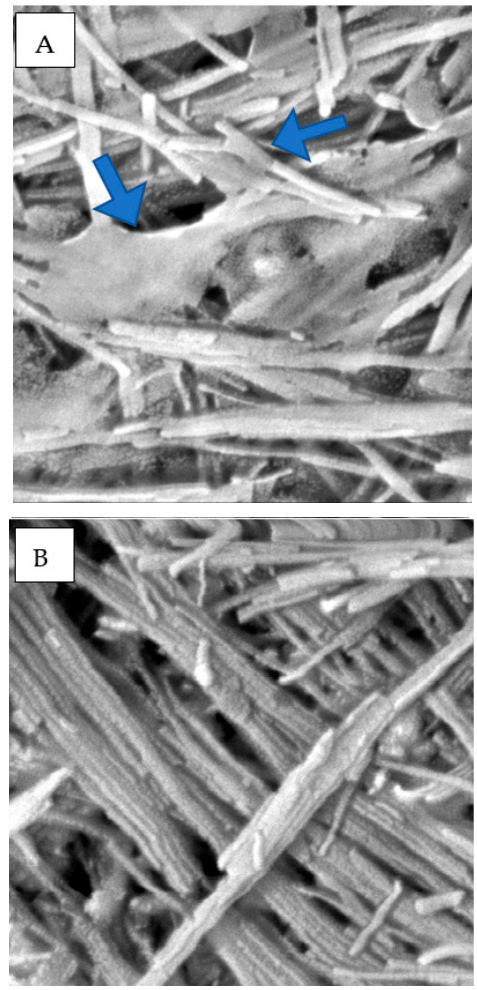
Figure 12. Surface morphology of FE before and after immobilization. The changes in morphology of immobilized YT PTE and FE at 50,000× magnification. ( A ) Immobilized YT PTE on FE; ( B ) FE alone.